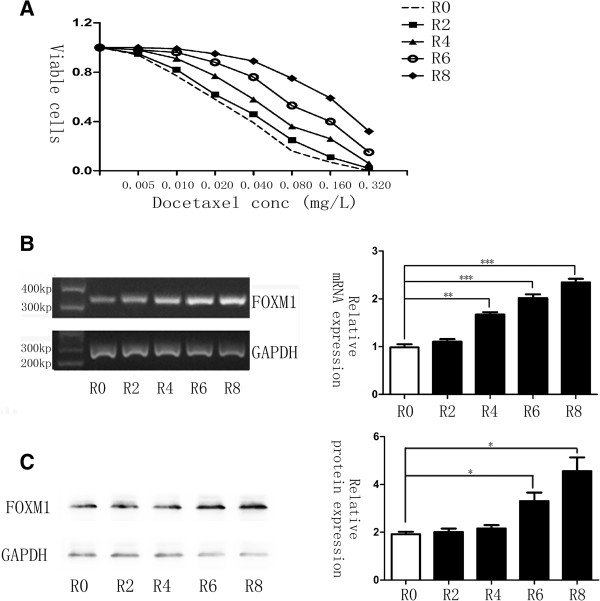
Docetaxel resistant cell line shows elevated FOXM1 mRNA and protein expression levels. (A) Cells in different cycle of molecular evolution assay were treated with docetaxel respectively, and their rates of cell viability were measured by MTT assay. R0 represents the untreated control cell line, whereas R2, R4, R6 and R8 represents AGS cells that are treated with 0.02 mg/L docetaxel for two, four, six and eight times, separately. IC50 for cells in R0, R2, R4, R6 and R8 was 0.026, 0.033, 0.054, 0.098, 0.190 mg/L. (B) FOXM1 mRNA transcript levels in R0, R2, R4, R6 and R8 cells were determined by RT-PCR analysis. (C) Western blot analysis was performed to detect the relative protein expression levels of FOXM1 in the different treated round. Statistical analysis was performed using Student’s t tests. *, P ≤ 0.05; **, P ≤ 0.01; ***, P ≤ 0.001 significant.